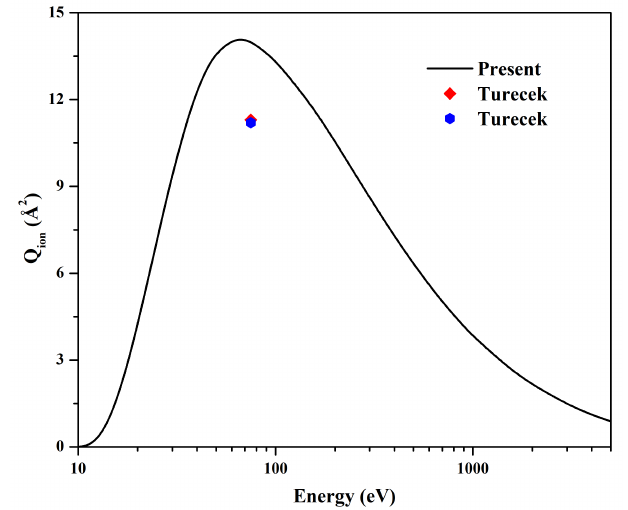
Figure 6. Q ion for cis-2-butenal. Solid line: present Q ion for cis-2-butenal; solid rhombus: theoretical Q ion calculated for cis-2-butenal by Tureˇcek et al. [12]; solid hexagonal: experimental Q ion calculated for cis-2-butenal by Tureˇcek et al.